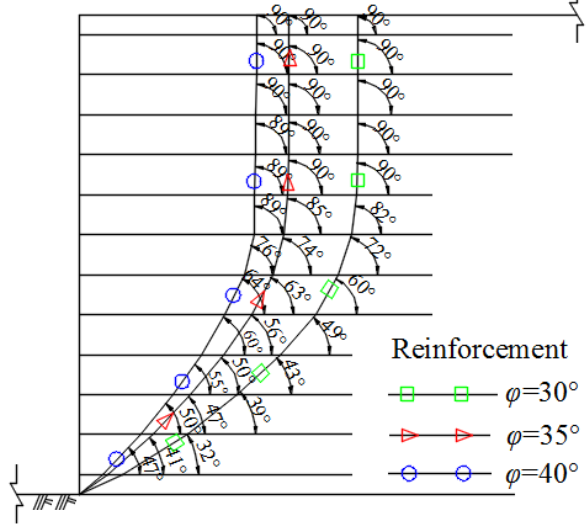
Figure 12. Inclination angle of slip surface and horizontal direction for various friction angles.